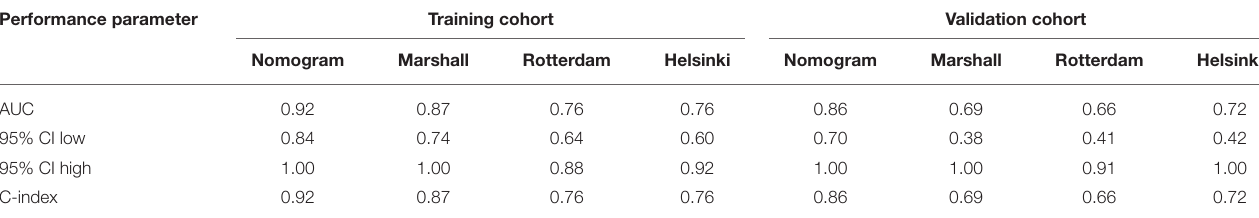
TABLE 4 | Performance of the nomogram in predicting early mortality in pediatric patients with TBI comparing with current CT scoring systems. Performance parameter